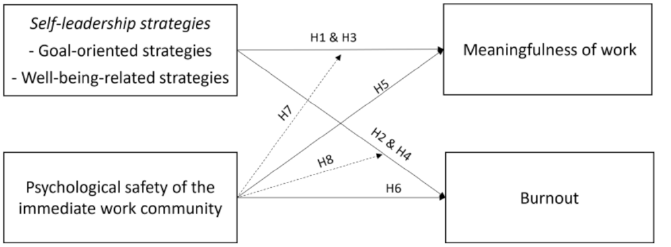
Figure 1. Conceptual model of the study and hypotheses tested. Dashed lines indicate the moderator effects